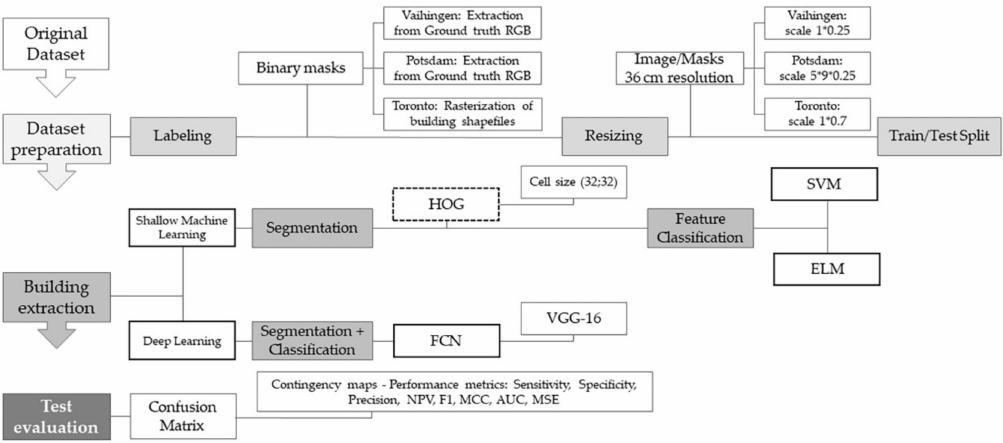
Figure 1. Overview of the study workflow steps: data retrieval and preparation (labeling, resizing, and train/test split), model implementation and training (building extraction), and test performance